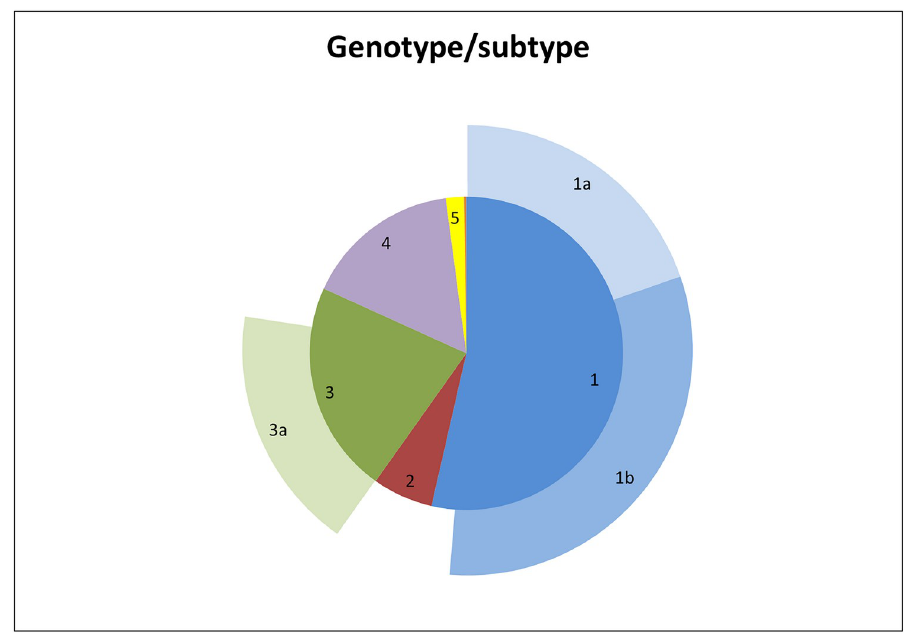
Fig 1. Schematic presentation of the genotype distribution (inner circle) within the Belgian population and the distribution of subtype 1a, 1b and 3a in relation to their genotype (outer circle). Due to the low prevalence, the genotype 7 cases were not